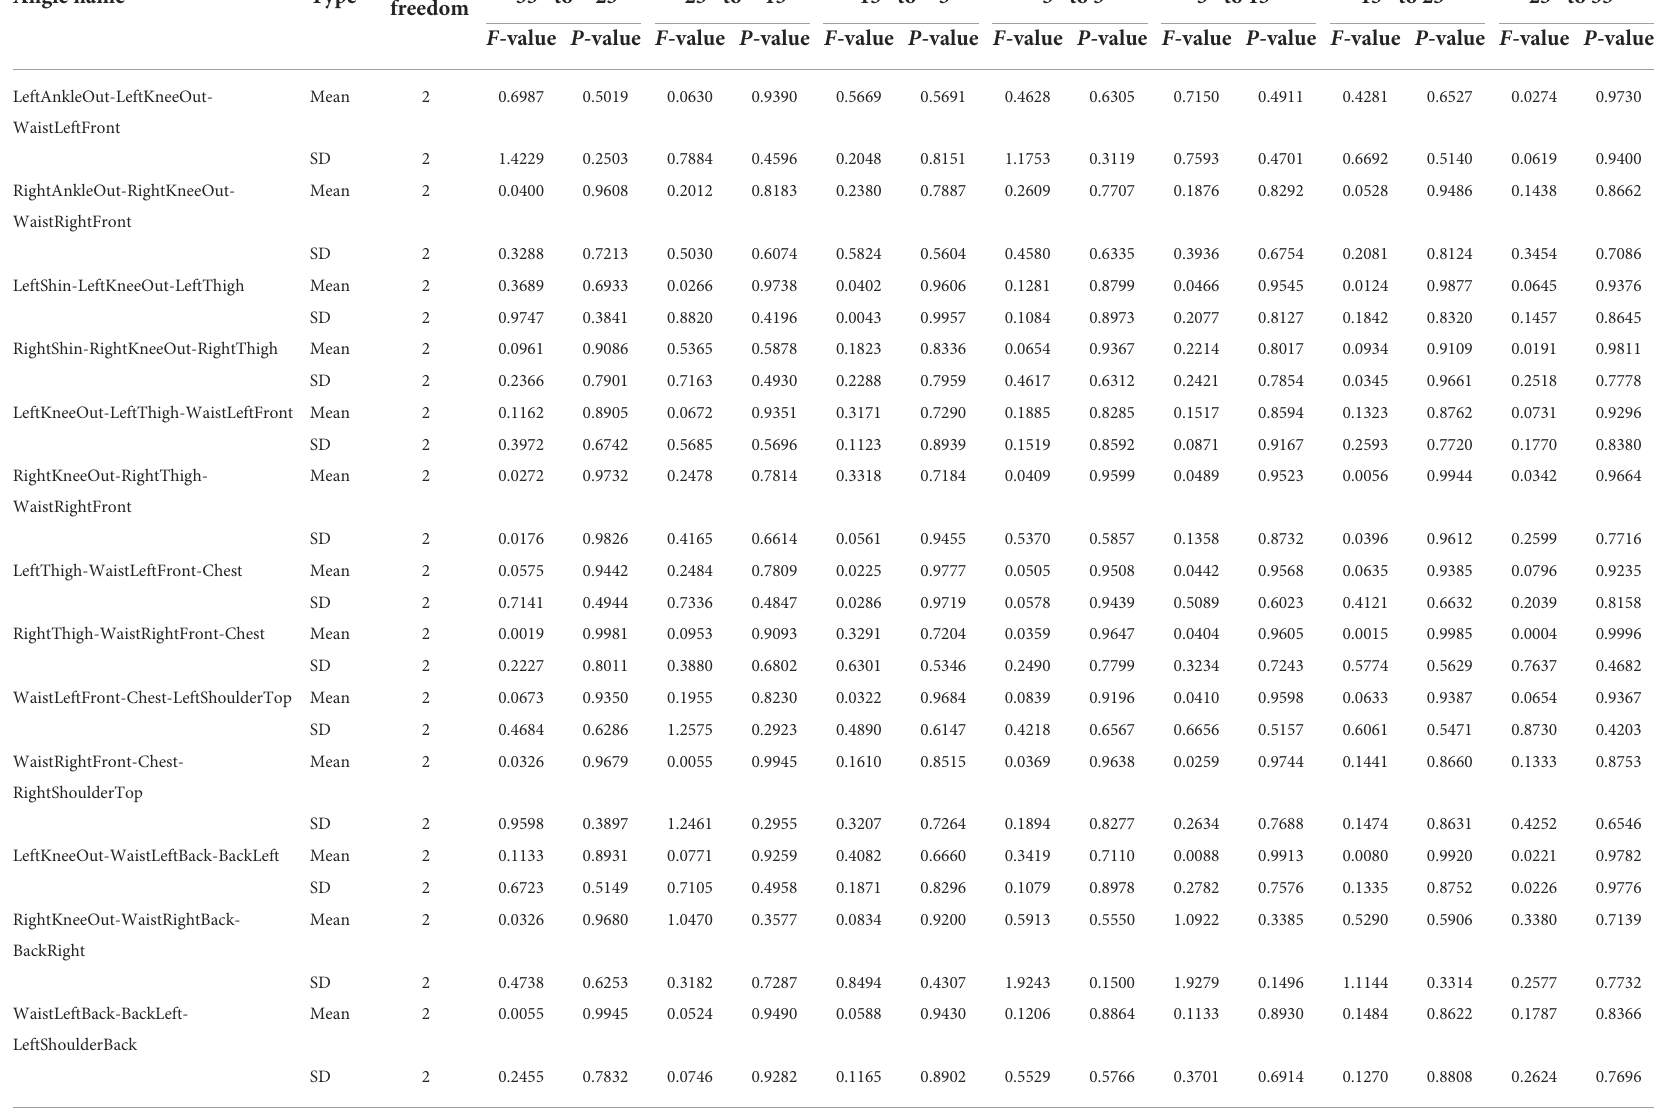
TABLE 4 Results of 1-way ANOVA for mean and SD of each angle in each straightness group (factor: expected